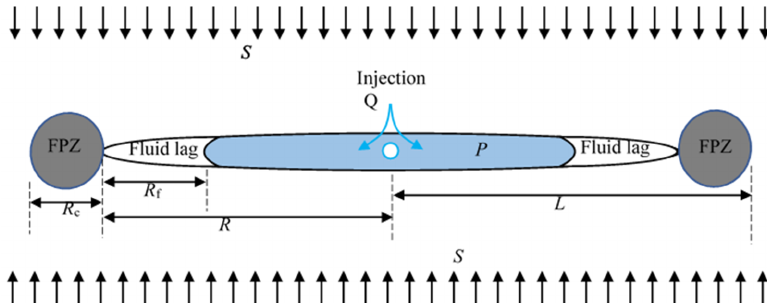
Figure 2. The schematic of the Fluid lag zone and FPZ in hydraulic fracturing.